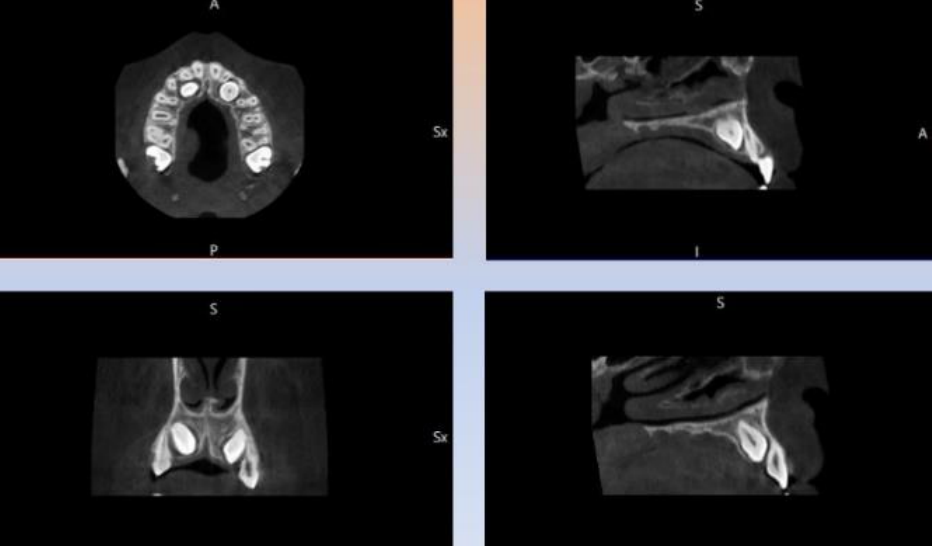
Figure 2. Particular projection of the patient’s CBCT with bilateral inclusion of the maxillary canines.